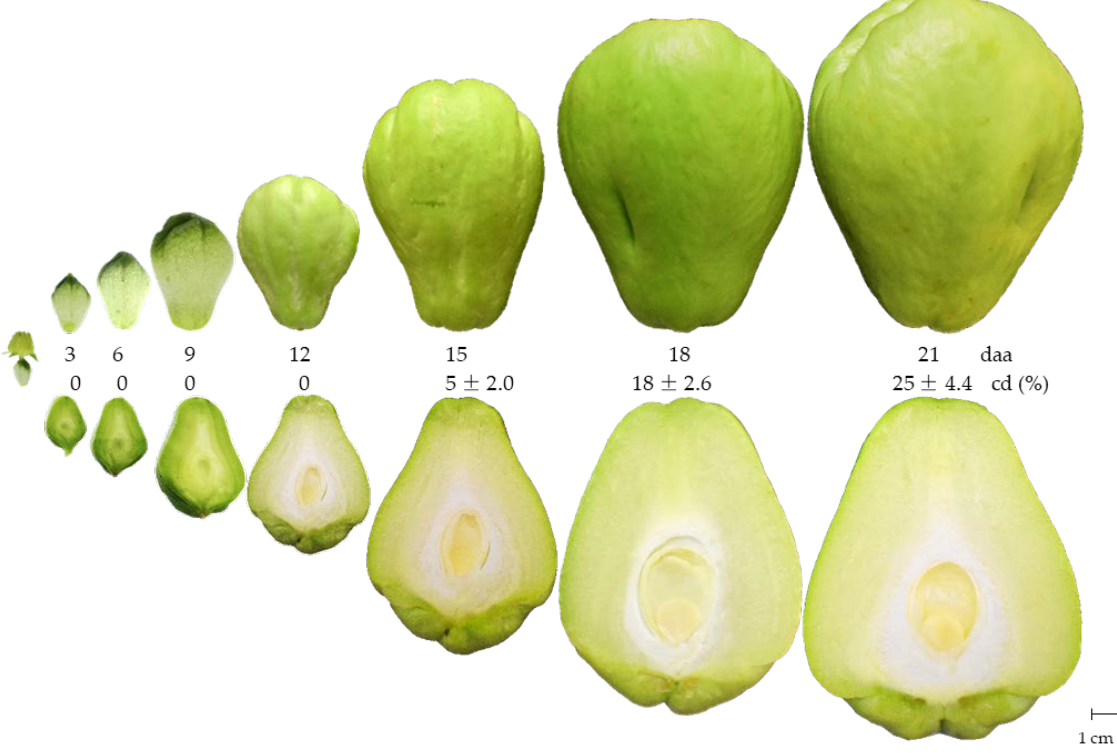
Figure 2. Fruit and seed development of chayote Sechium edule var. virens levis at 3, 6, 9, 12, 15, 18, and 21 daa = days after anthesis; cd = cotyledon development ( n = 10 ± standard deviation).